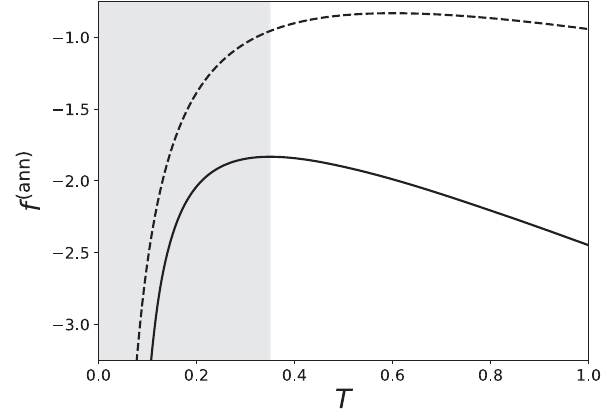
FIG. 1. Sketch of a bound on the annealed free energy (dashed) which might result from the present analysis, as compared to the exact annealed free energy (solid). The curves shown are merely illustrations, not results for any specific model. The important feature is that the bound diverges to −∞ as T → 0 , forcing the exact curve to do so as well. The shaded region is where s ð ann Þ ≡ − ∂ f ð ann Þ = ∂ T < 0 and the annealed approximation must be